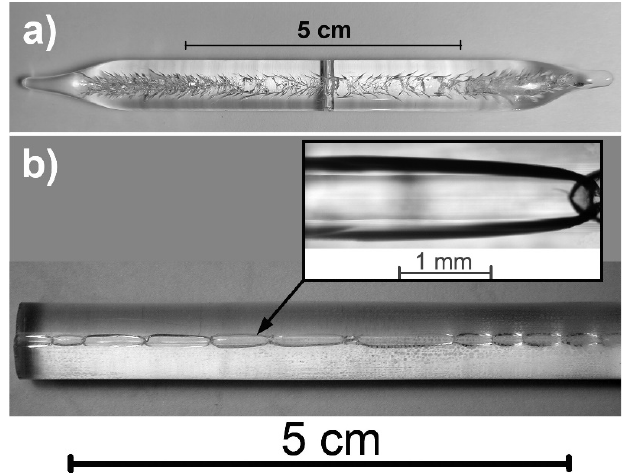
Figure 5. ( a ) Picture of the BS preform after stressed core cracking in the process of preform cutting with a diamond blade. The tensile stress in the core was 50 MPa, and the crack propagation velocity was >1 m/s. ( b ) For comparison, picture of cracking of the PS1 preform with lower residual tensile stress (preform with low level of P 2 O 5 dopant). The crack propagation velocity was ~2 × 10 − 3 mm/s. The inset shows a section of the preform on a larger scale. Here, one can see the core of the preform surrounded by an ellipsoidal crack.